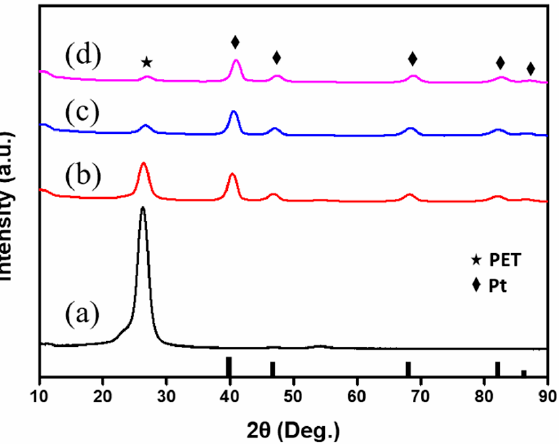
Figure 2. XRD patterns of the ( a ) PET film and the Pt/PET prepared with ( b ) 30 min, ( c ) 45 min and ( d ) 60 min of the Pt deposition time. (JCPDS card No 87 ‐ 0647). ( d ) 60 min of the Pt deposition time. (JCPDS card No